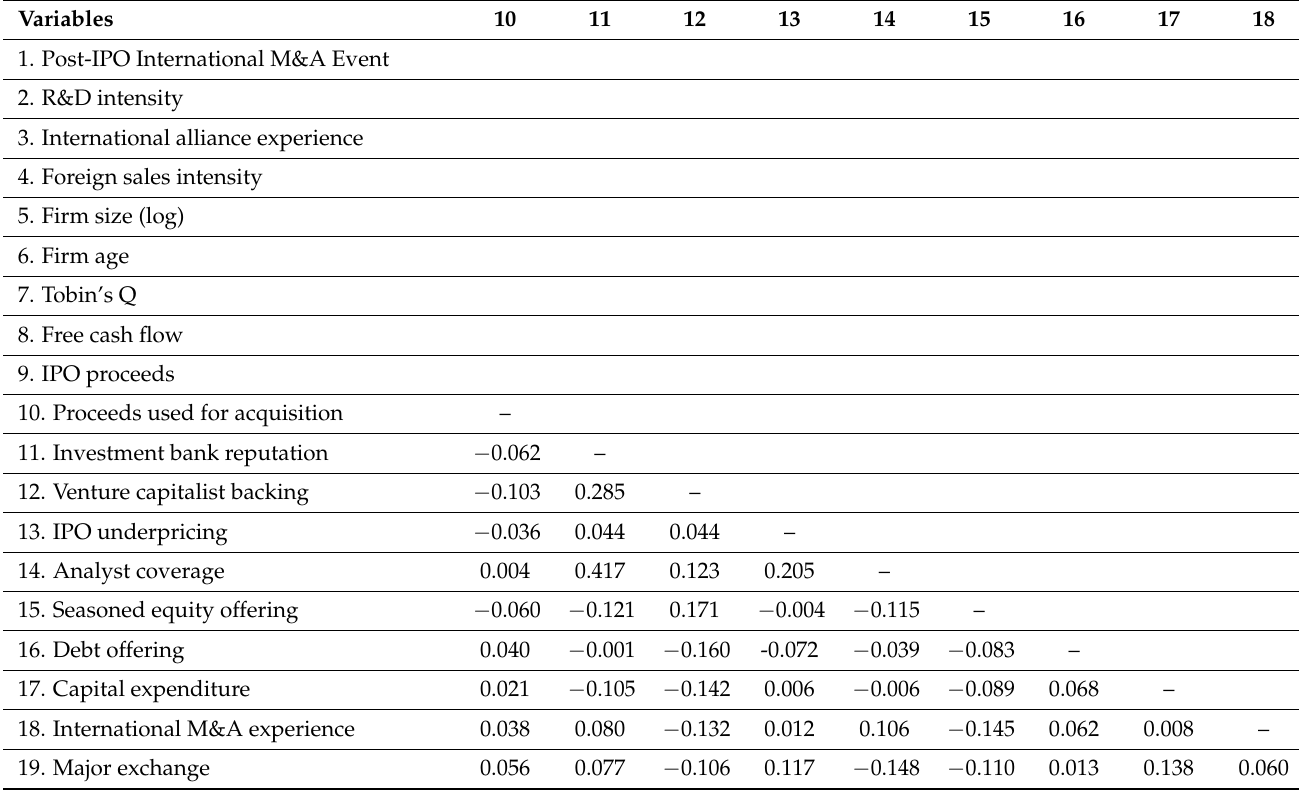
Table 1. Descriptive Statistics and Correlation Matrix